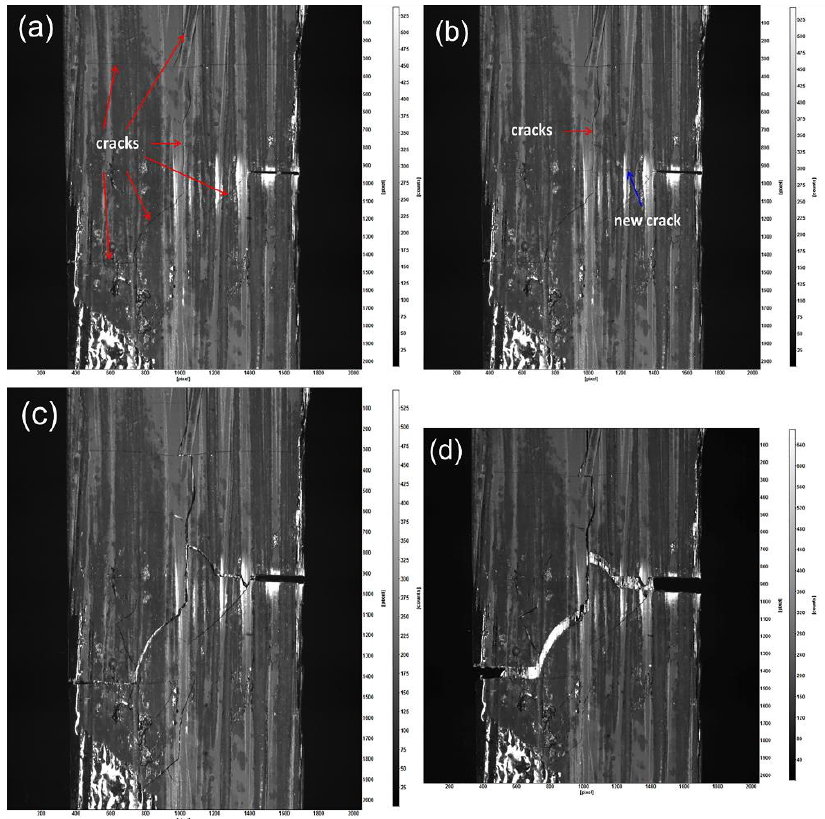
Figure 6. The whole fracture process of sample NC_2: ( a ) microcracks in the matrix; ( b ) a new crack initiated along the notch; ( c ) cracks opening and coalescence under tension; ( d ) complete fracture of the whole